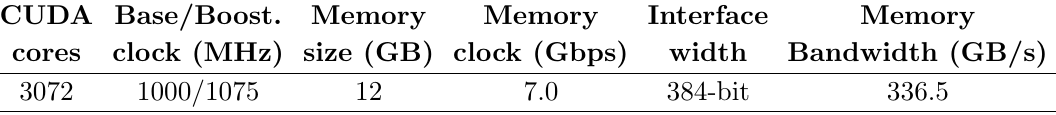
Table 1. Manufacturer speci(cid:12)cations of the GTX